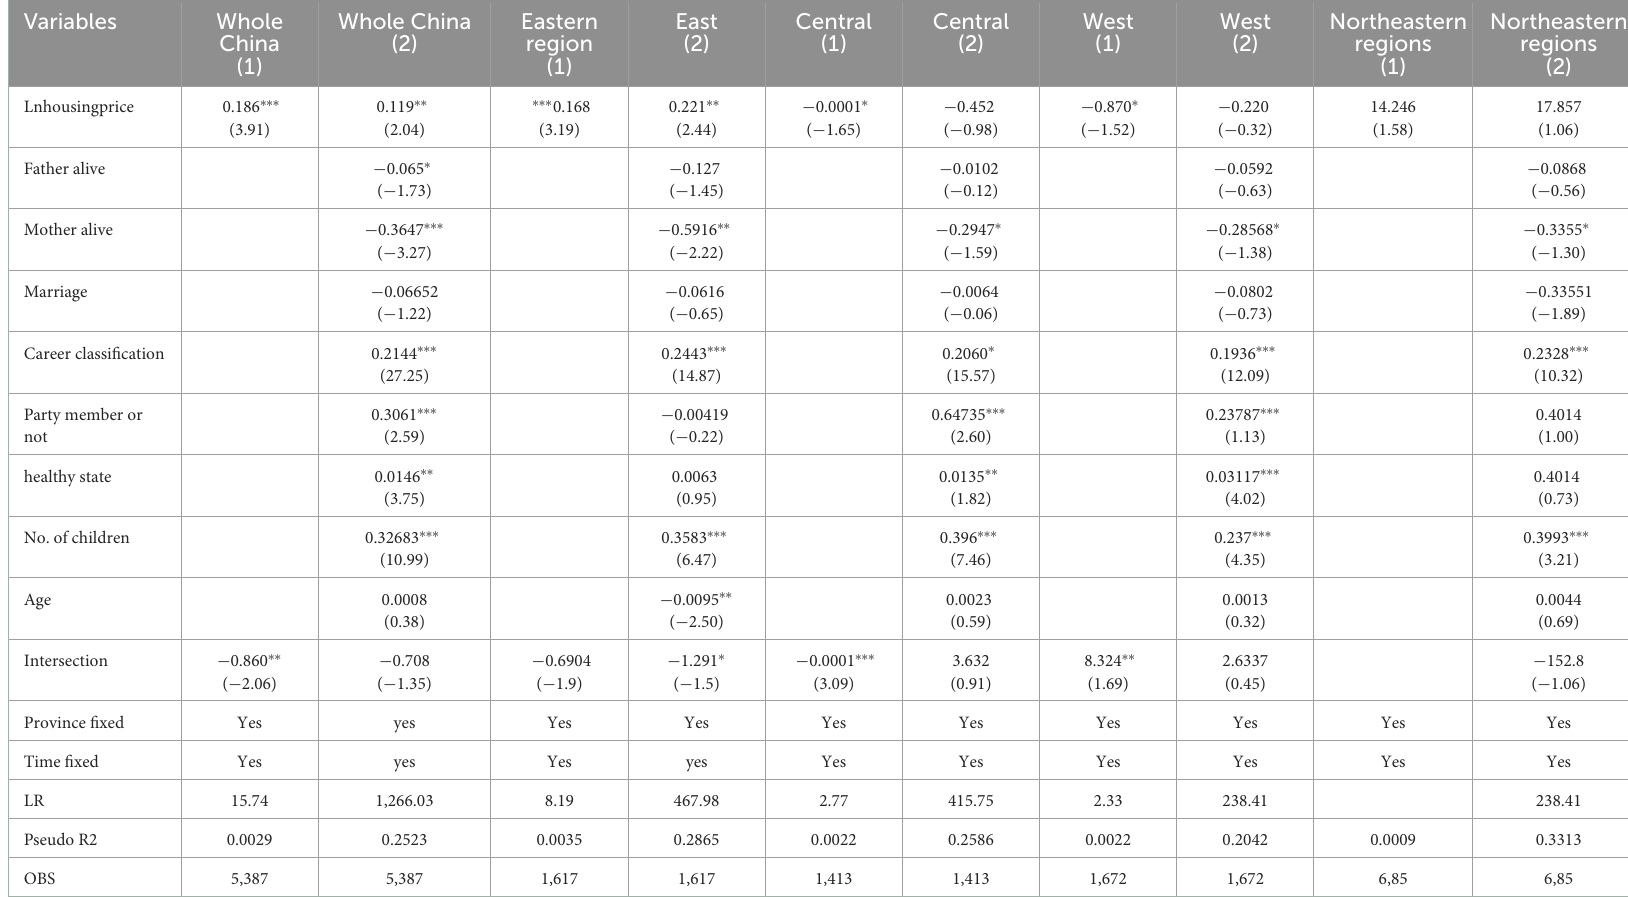
TABLE 2 Results of the impact of housing price on